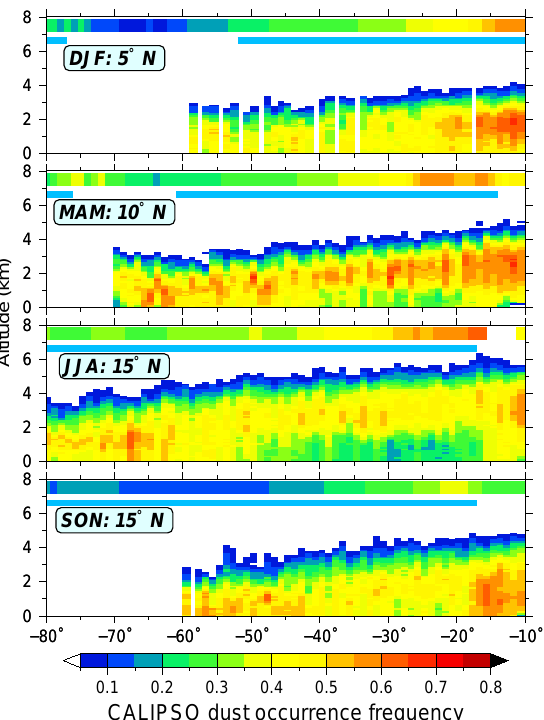
Fig. 6. Vertical distribution of the dust aerosols occurrence frequency above the Atlantic Ocean (from top to bottom) during winter (DJF at 5 ◦ N), spring (MAM at 10 ◦ N), summer (JJA at 15 ◦ N) and fall (SON at 15 ◦ N). The abscissa is the longitude from 80 ◦ W to 10 ◦ W. The cyan line at 6.5 km of each cross section marks the ocean, while the colour line above it, between 7 and 8 km , is the MODIS AOD at 550 nm . The colorbar of MODIS AOD is the same as that of the dust occurrence frequency.